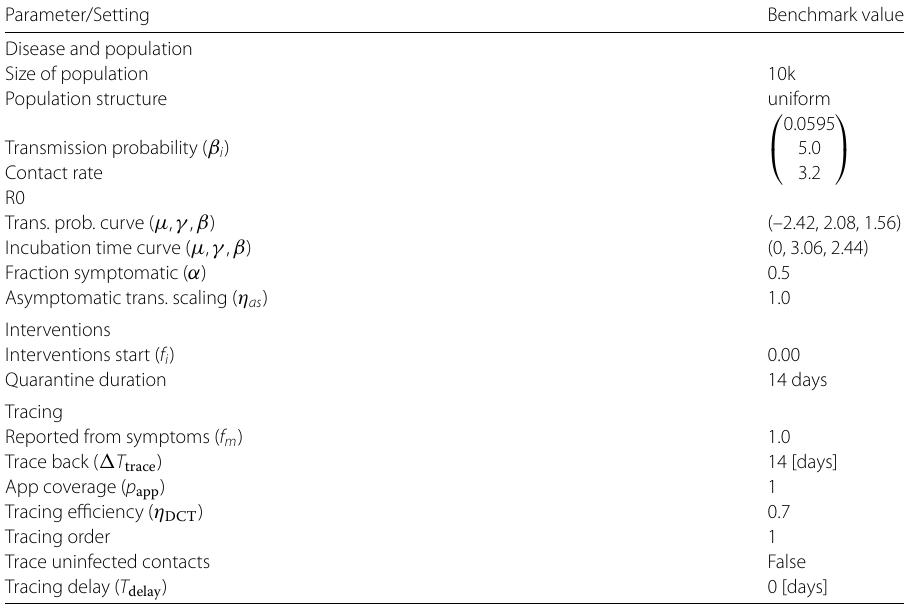
Table 4 Table of settings used to benchmark the four models against each other